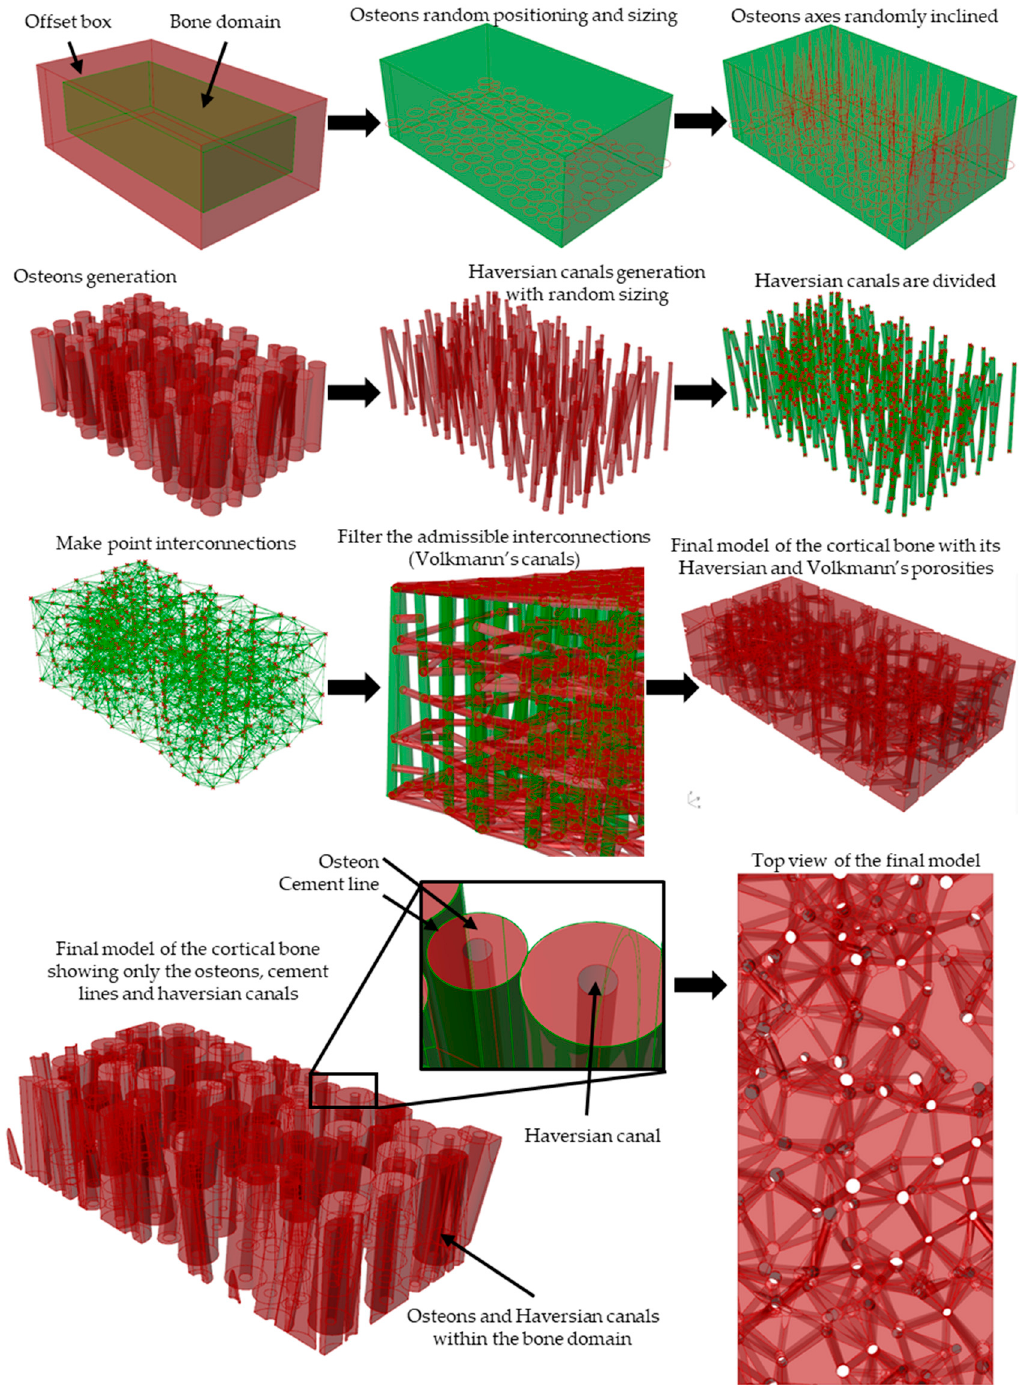
Figure 3. Step-by-step modeling process according to the algorithm.